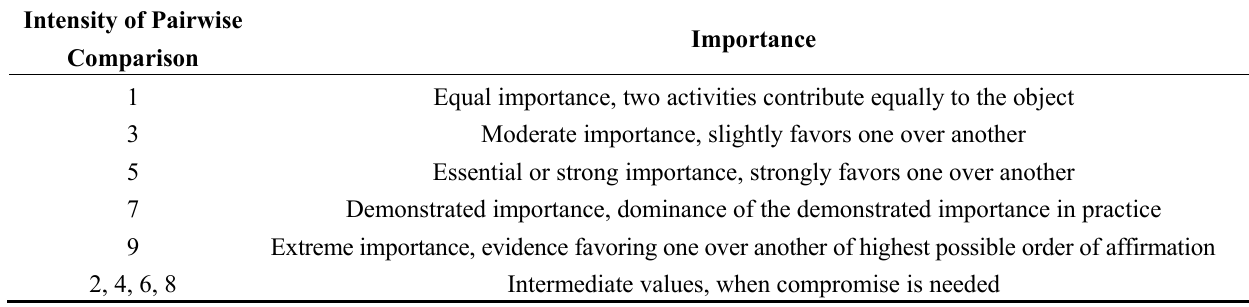
Table 2. Nine-point scale for pairwise comparison.